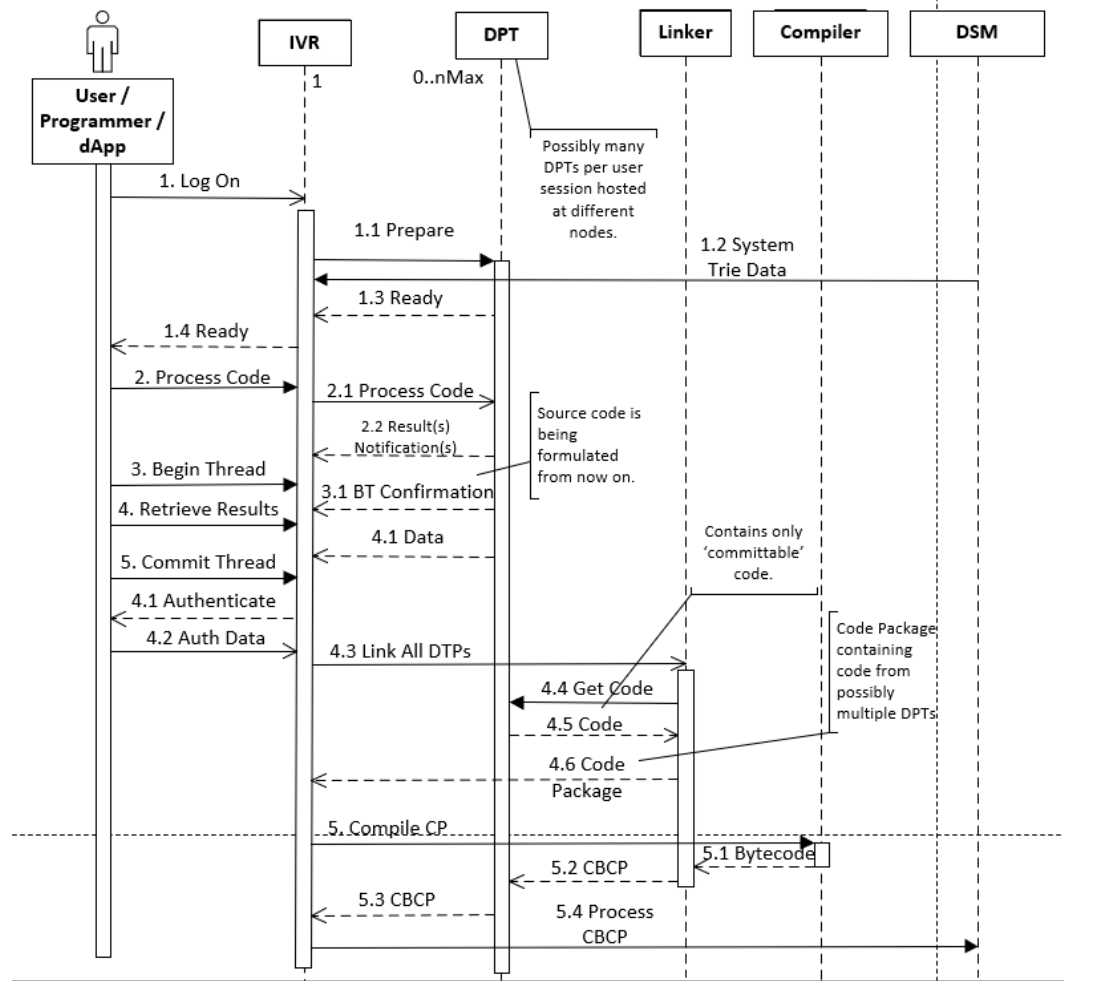
Figure 9. From ‘log-on’ to a broadcasted bytecode package.